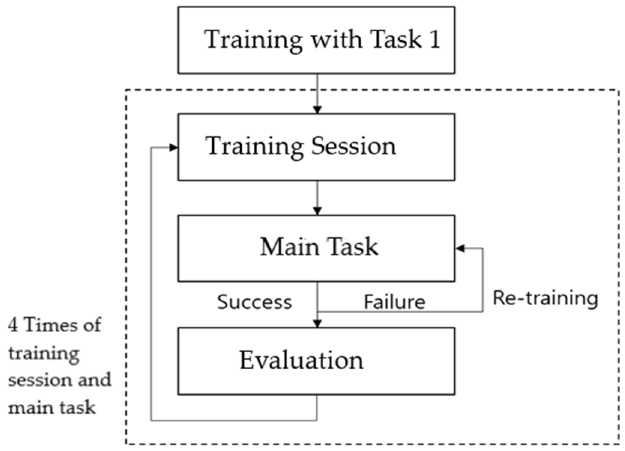
Figure 5. Experimental procedure.